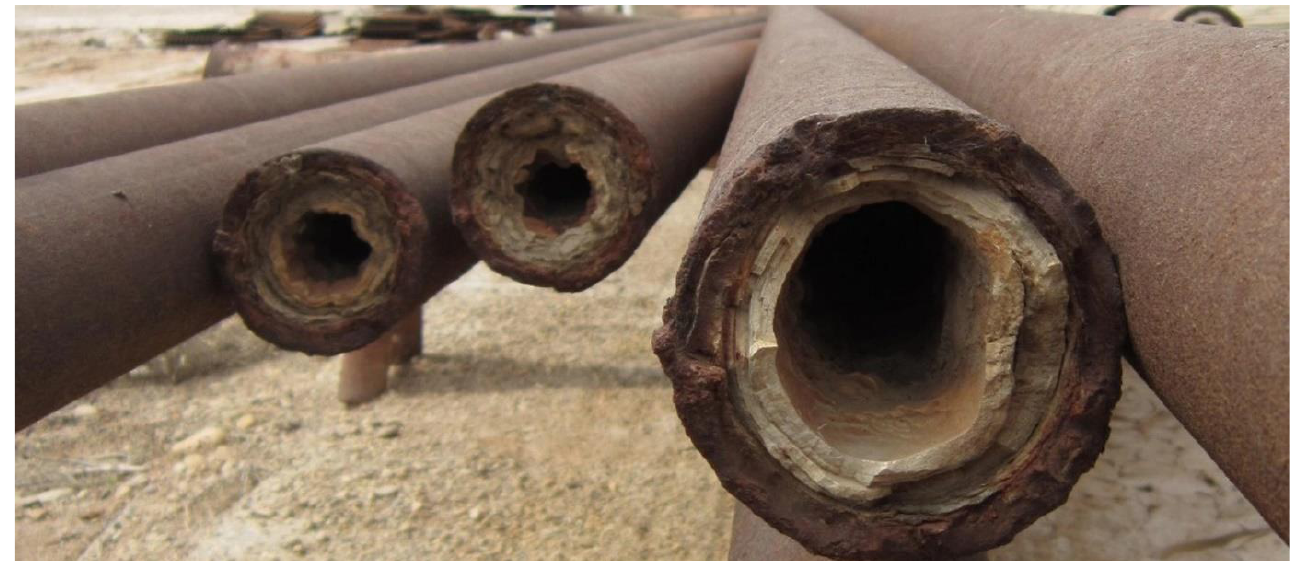
Figure 1. An example of scale deposition in few pipes.